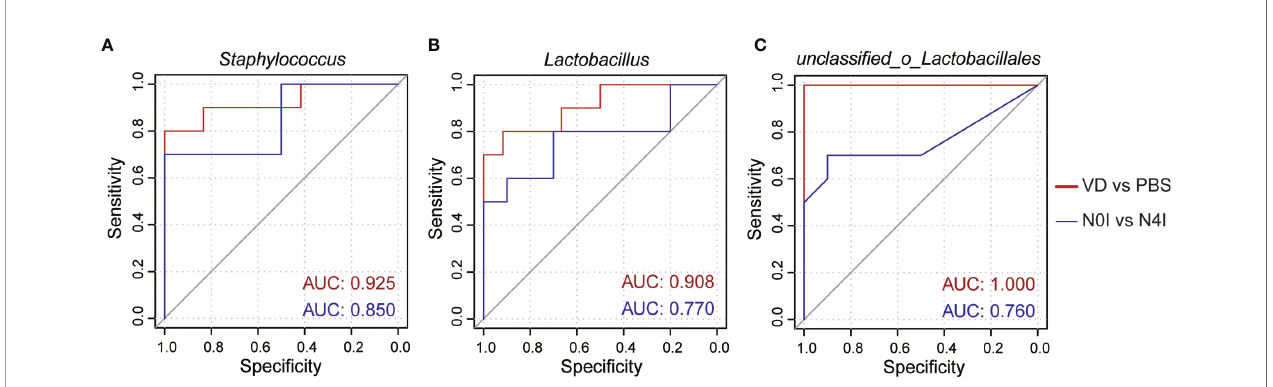
FIGURE 5 | The area under curves of potential bacterial biomarkers in discriminating mCRAMP-treated mice from control subjects. (A – C) ROC curves of three selected bacterial marker candidates, including Staphylococcus (A) , Lactobacillus (B) , and unclassi fi ed_o_Lacobacillales (C) , were calculated to determine the ef fi cacy of reshaped gut microbiota composition in mCRAMP-treated mice. AUC values close to 1 indicate that a high true positive rate was achieved with low false positive rate (ideal performance), while AUC values close to 0.5 indicate